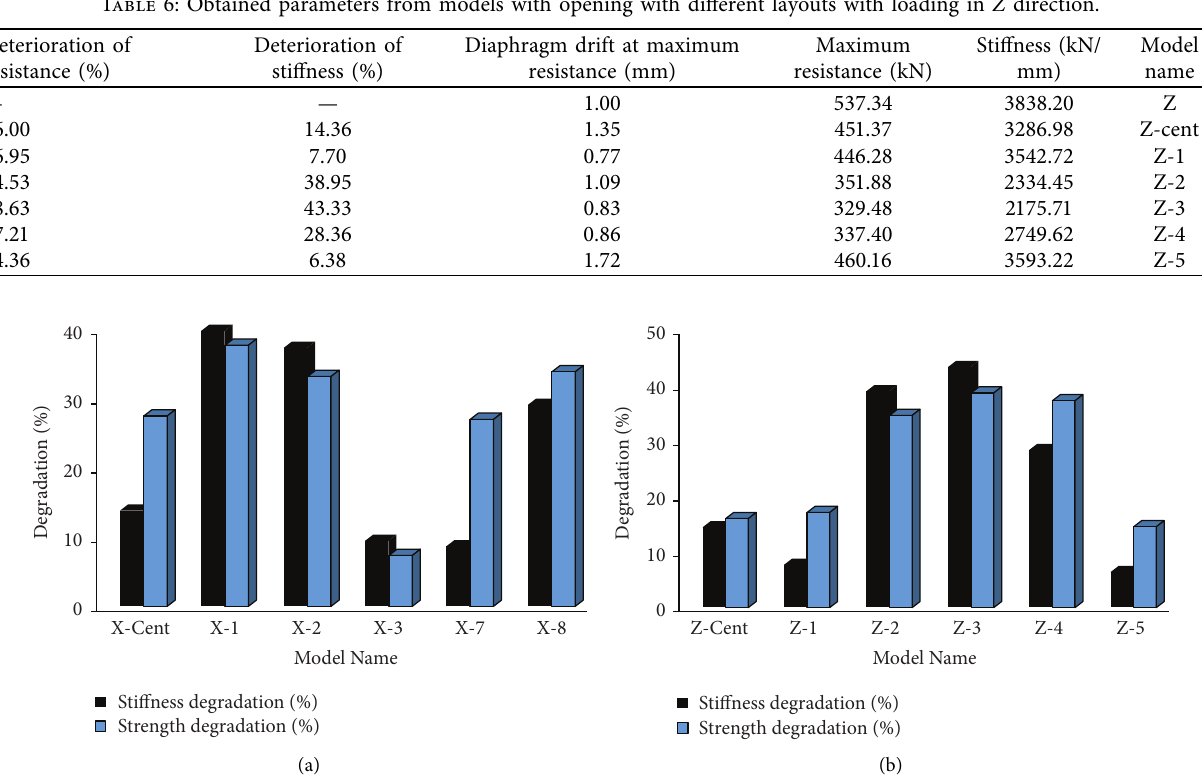
Figure 17: Chart of stiffness deteriorating percentage and ultimate strength for models with opening with loading in various directions. (a) Loading in X direction. (b) Loading in Z direction.